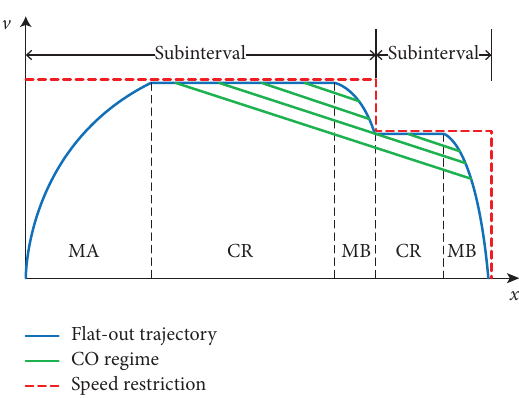
Figure 3: Te illustration of fat-out trajectory and coasting re- gimes addition.